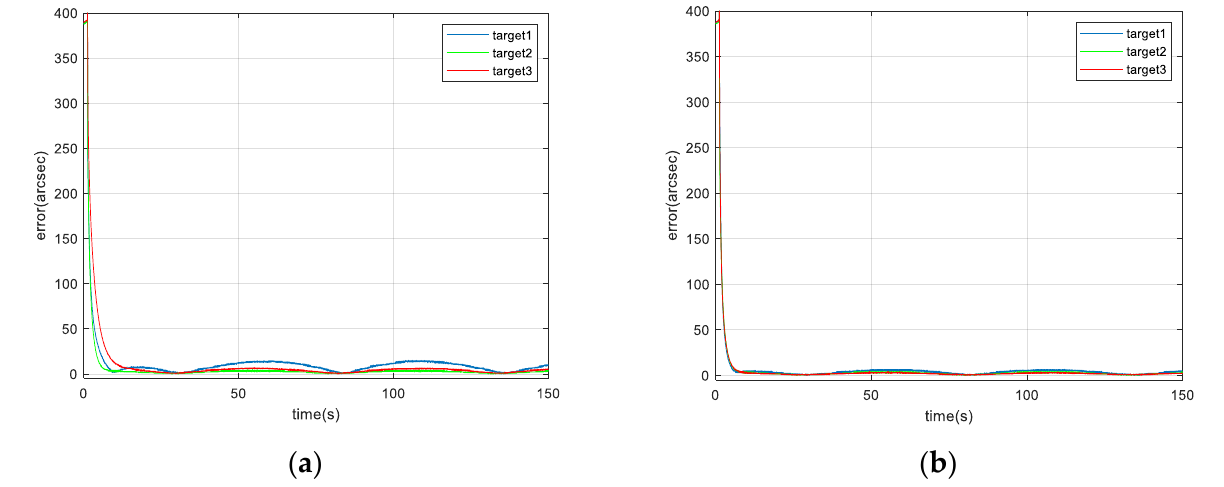
Figure 15. IBCLT error of different moving targets obtained with ( a ) fixed gain control and ( b ) variable gain control techniques.